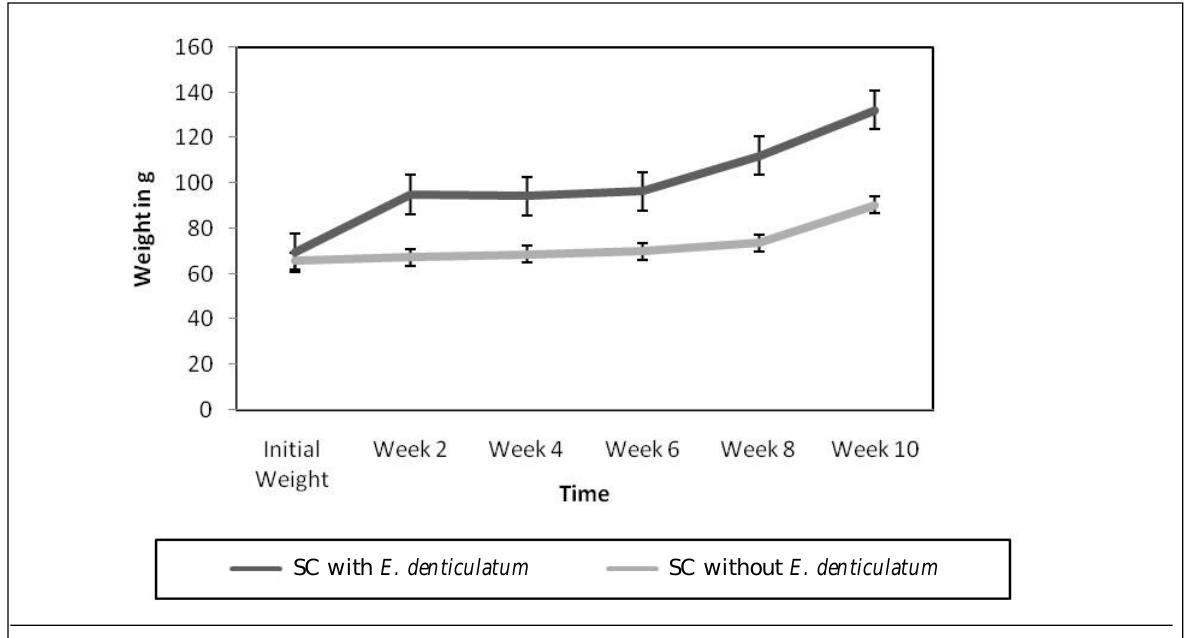
Figure 2: Comparison of mean (± SD) weekly body weight of individual sea cucumber co-cultured with E. denticulatum and without E. denticulatum Similarly the survival of H. scabra was higher (80%) in pens in which it was co-cultured with E. denticulatum than in pens (76%) in which it was cultured without E. denticulatum . For the seaweed E. denticultum , both growth rate (7.31 g d –1 ) and survival (58.89%) were higher in pens with H. scabra than in pens without H. scabra ( growth rate = 6.801g d –1 and survival = 56.67%). However, the analysis of variance reveals no significant differences in growth rate among the treatments ( F = 2.81, p = 0.144 ) (Figure 3). The final biomass weight of H. scabra in pens co-cultured with K. alvarezii was higher (140.76 ± 10.16 g) compared to that recorded in pens (118.89 ± 6.94 g) without K. alvarezii . SGR was also higher (1.038 gd –1 ) in pens with K. alvarezii than in pens without K. alvarezii (0.734 gd –1 ). Results for weakly measurements revealed slight variation in growth rate between co-cultured H. scabra (93.62 g ± 10.16 g) and sea cucumber cultured without K. alvarezii (87.48 ± 10.16 g) (Figure 4). No significance difference on growth was observed between the treatments ( p = 0.377).